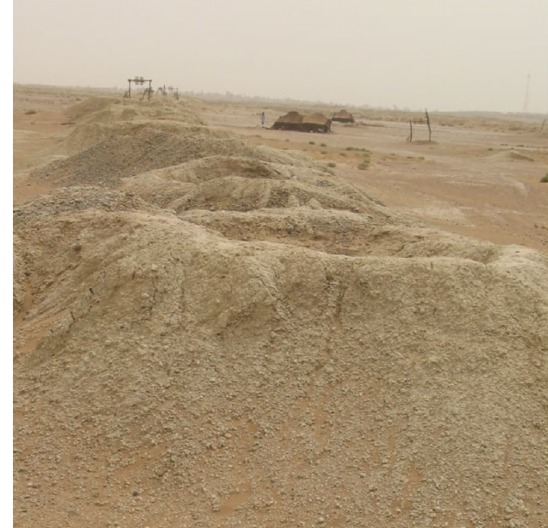
Fig. 10 Photo of khettaras’ network organised for tourism in Tafilalet (Source: the